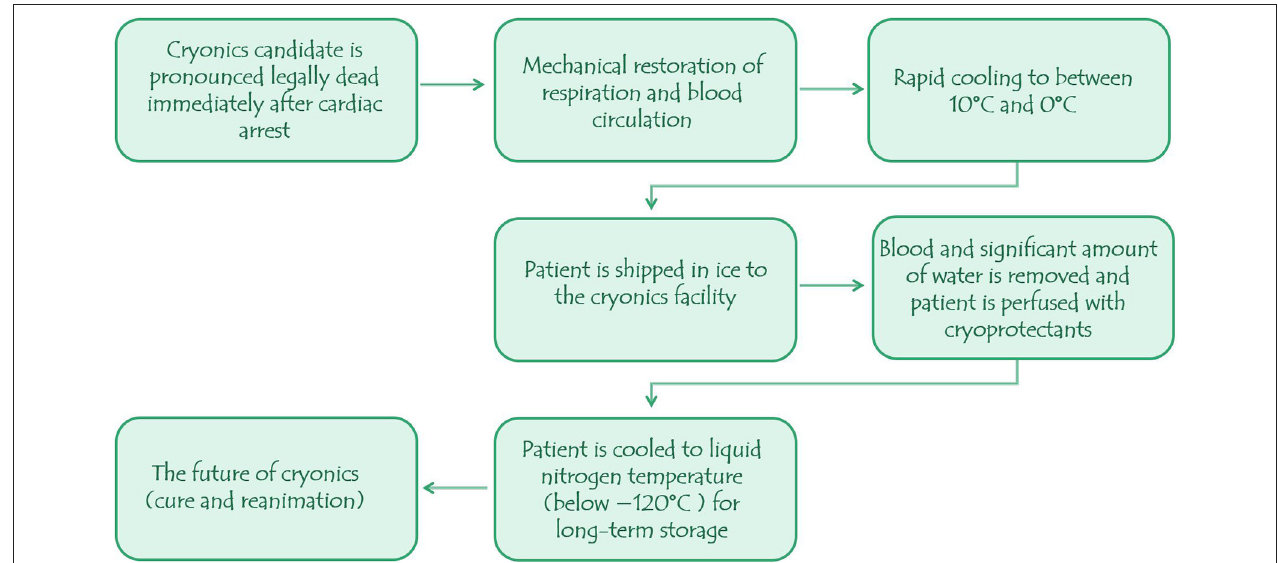
FIGURE 1 | The procedure in